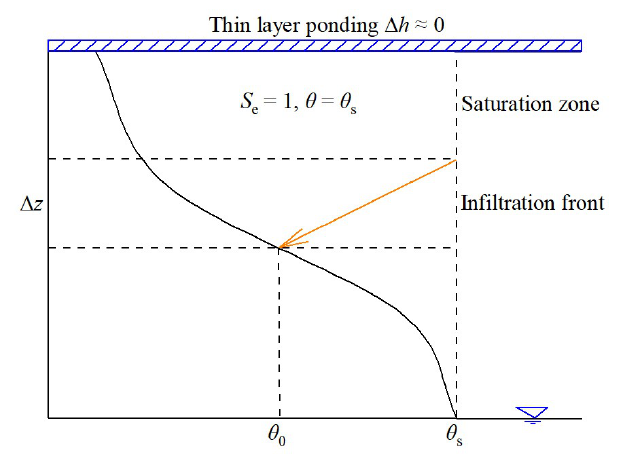
Figure 5. Schematic diagram of soil water infiltration.